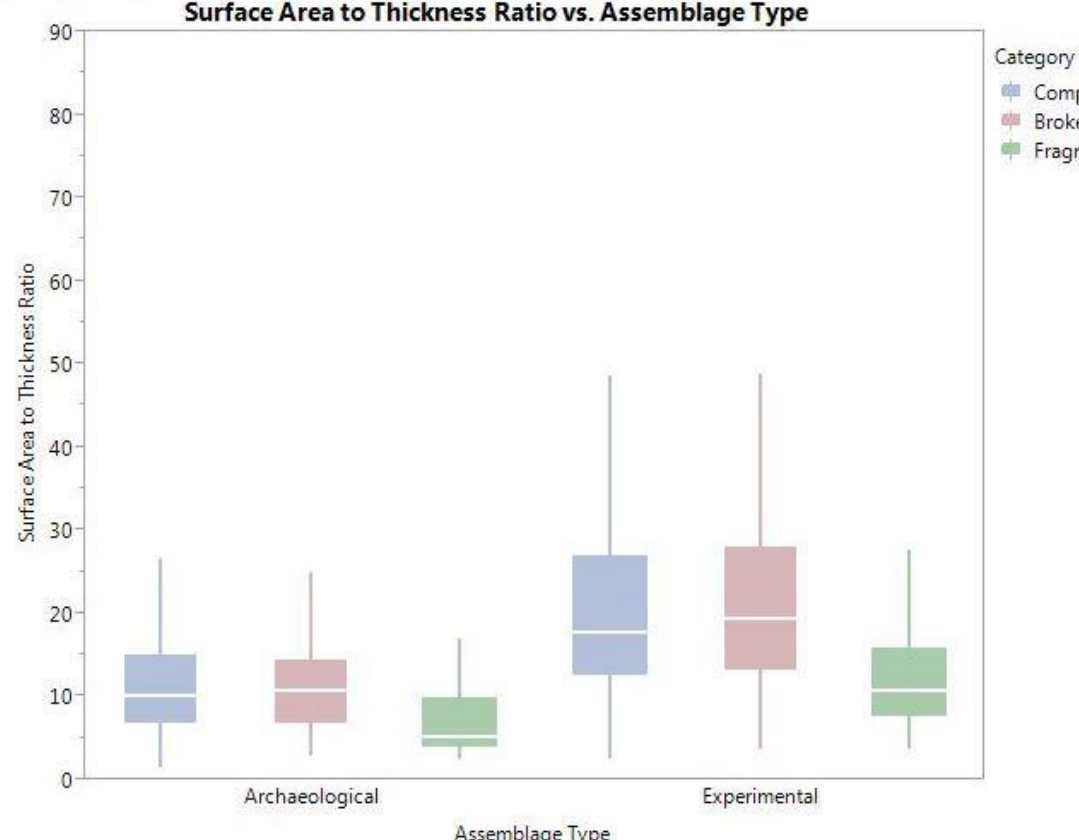
Figure 3. Box plots of surface area to thickness ratios of the different breakage categories and assemblage